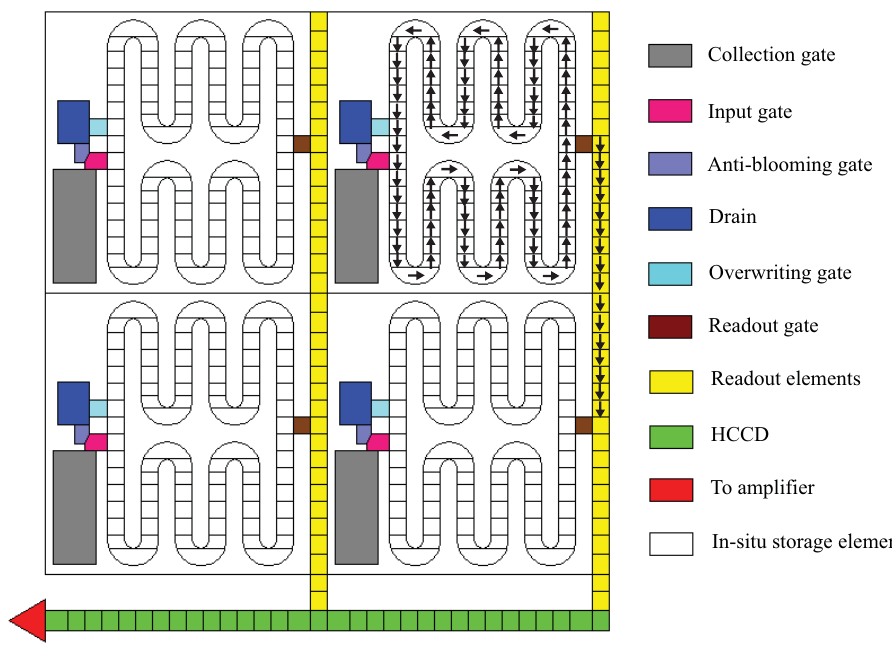
Figure 5. ISAS architecture on the front-side [9].